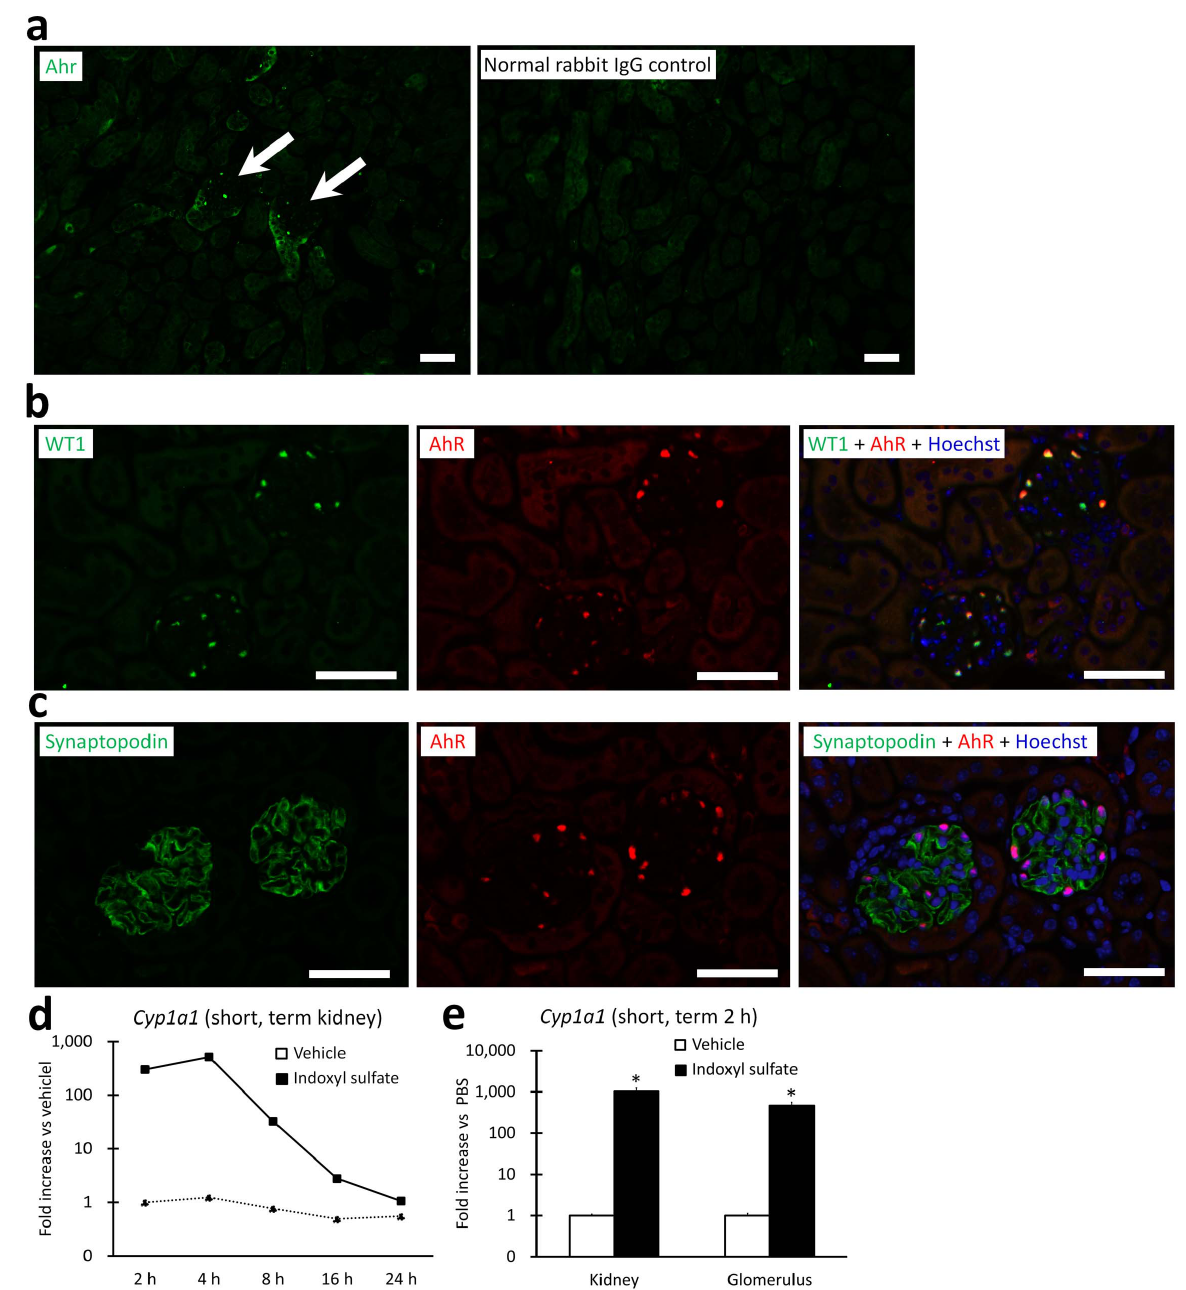
Figure 3. AhR localized predominantly to podocyte nuclei in mouse kidneys. Immunostaining of renal cortices from normal C57BL/6 mice for AhR (green) and normal rabbit IgG control ( a ). The arrows indicate glomeruli containing AhR-positive cells. In the renal cortex, AhR-positive cells were restricted to the glomeruli, and no positive reaction was observed in normal rabbit IgG controls. Immunostaining for WT1 (green), AhR (red), and a merged image with Hoechst nuclear stain (blue); some nuclei are yellow, suggesting that podocyte nuclei contain AhR ( b ). Immunostaining for synaptopodin (green), AhR (red), and a merged image with Hoechst nuclear stain (blue) ( c ). Nuclei expressing AhR and surrounded by synaptopodin- positive cytoplasm, confirming podocyte localization. Bars=40 m m. The induction of Cyp1a1 mRNA in the kidneys and glomeruli of C57BL/6 mice exposed to vehicle or indoxyl sulfate (800 mg/kg, i.p. given as a single dose). The time course of Cyp1a1 mRNA expression in the kidneys at the time points shown following the final dose as assessed by performing real-time PCR ( d ). Cyp1a1 mRNA expression in the kidneys and isolated glomeruli at 2 h after dose ( e ). n $ 3, mean 6 S.D. * denotes significant differences between the vehicle and indoxyl sulfate groups ( P , 0.05). doi:10.1371/journal.pone.0108448.g003 Ser71. Phosphorylated Rac1/Cdc42 increased at 30 and 120 min predominantly cortical actin. Ser71 phosphorylation of Rac1/ Cdc42 GTPase increases filopodial structures, cell motility, and after indoxyl sulfate exposure, consistent with a shift toward a migration [34], and phospho-Rac1/Cdc42 (Ser71) antibody motile phenotype (Figure 5f). detects endogenous Rac1/Cdc42 only when phosphorylated at